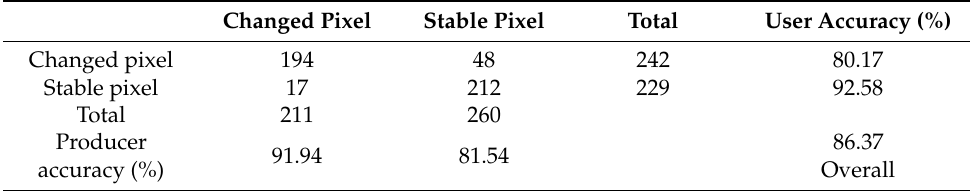
Figure 4. Examples of disturbance in Google Earth images showing the pre-disturbance (2008/2009) and post-disturbance (2016) of the savannah. Currently, the vegetation is being cleared due to farming. Table 1. Accuracy assessment of the change